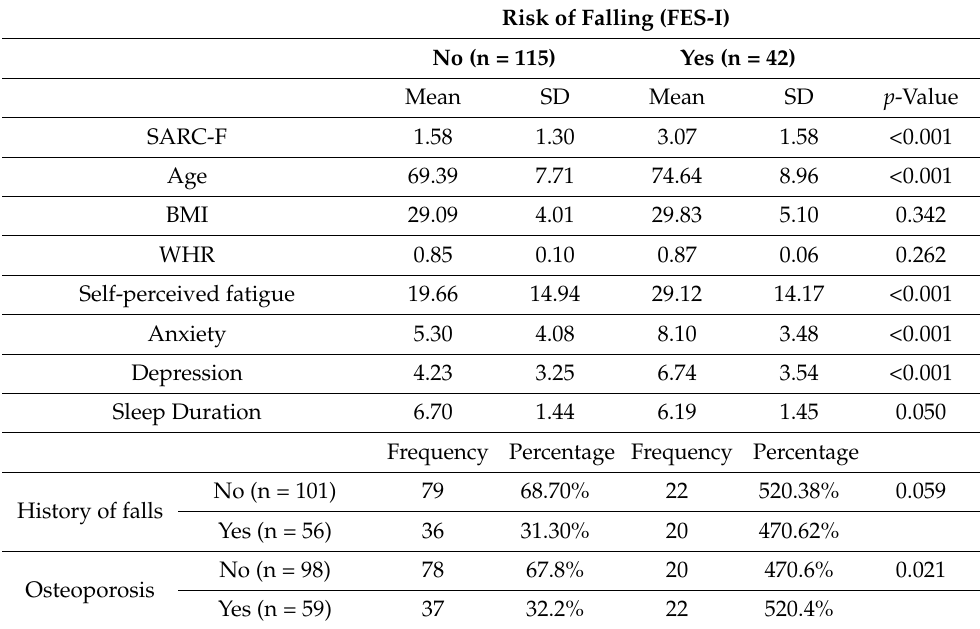
Table 2. Individual differences in SARC-F and possible confounders regarding the risk of falling